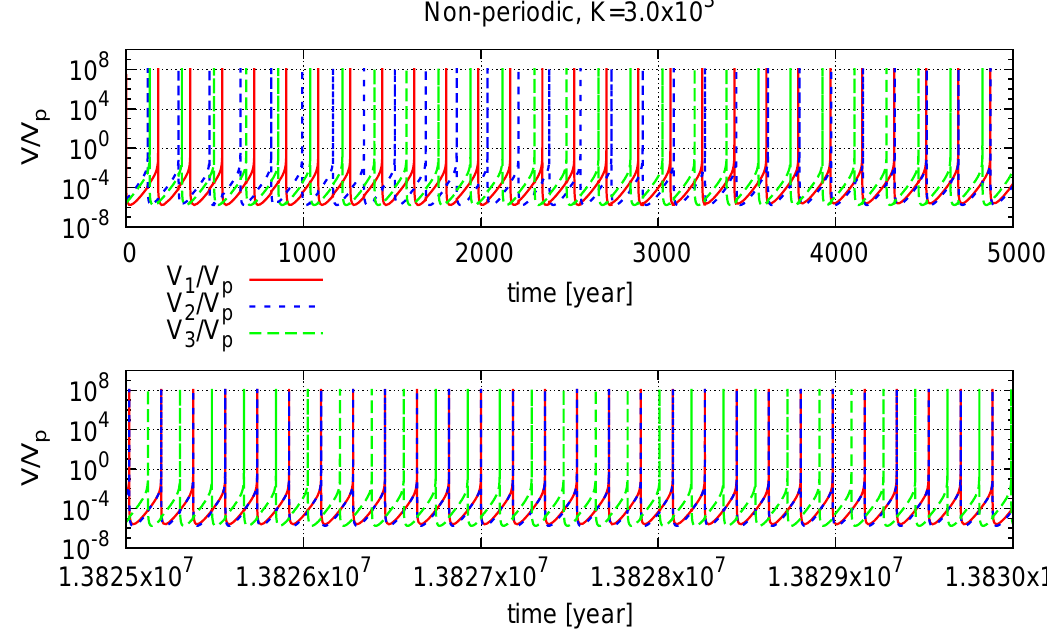
Fig. 12. The time evolution of V/V p for three identical oscillators with a non-periodic one-dimensional coupling in a logarithmic scale. Red, blue, and green curves correspond to oscillators 1, 2, and 3, respectively. The variation from 5000 to 13825000yr is not shown. The initial states for three oscillators are different from each other. The parameters are B = 2 . 20 × 10 5 Nm − 2 for all oscillators, and k 12 = k 23 = 3 × 10 3 Nm − 3 , k 31 = 0 (non-periodic one-dimensional coupling). They synchronize at the phase differences of (ψ 1 ,ψ 3 ) ’ ( 7 . 0 × 10 − 3 , 2 . 6 ) , where oscillators 1 and 2 are nearly in-phase. This synchronization corresponds to a stable node in Fig. 14. Nonlin. Processes Geophys., 21, 251–267,